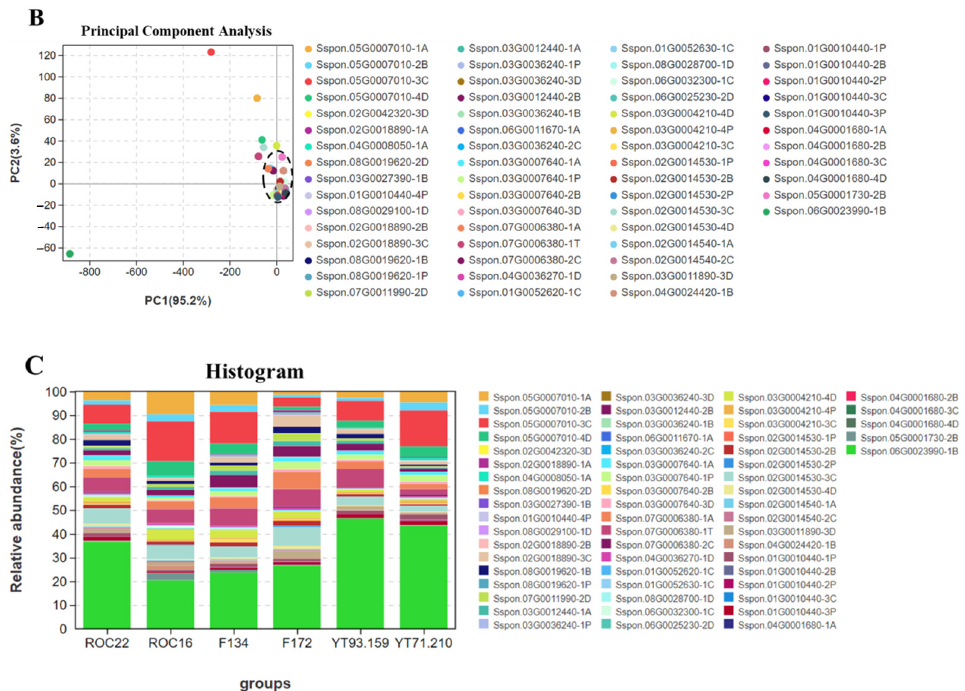
Figure 5. Heat map, principal component analysis, and histogram analysis of transcriptomic data (six sugarcane varieties). ( A ) Heat map of transcriptomic data associated with amino acid biosynthesis genes (the row represents gene expressions and columns signify sugarcane varieties). ( B ) PCA of individual genes distributed on x -axis and y -axis. ( C ) Histogram analysis of the expression level of the individual gene associated with amino acids biosynthesis in six sugarcane varieties.